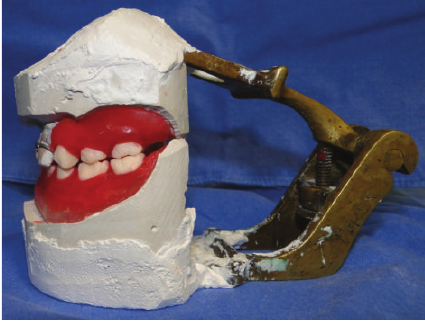
Figure 7: Working casts mounted in a simple articulator.